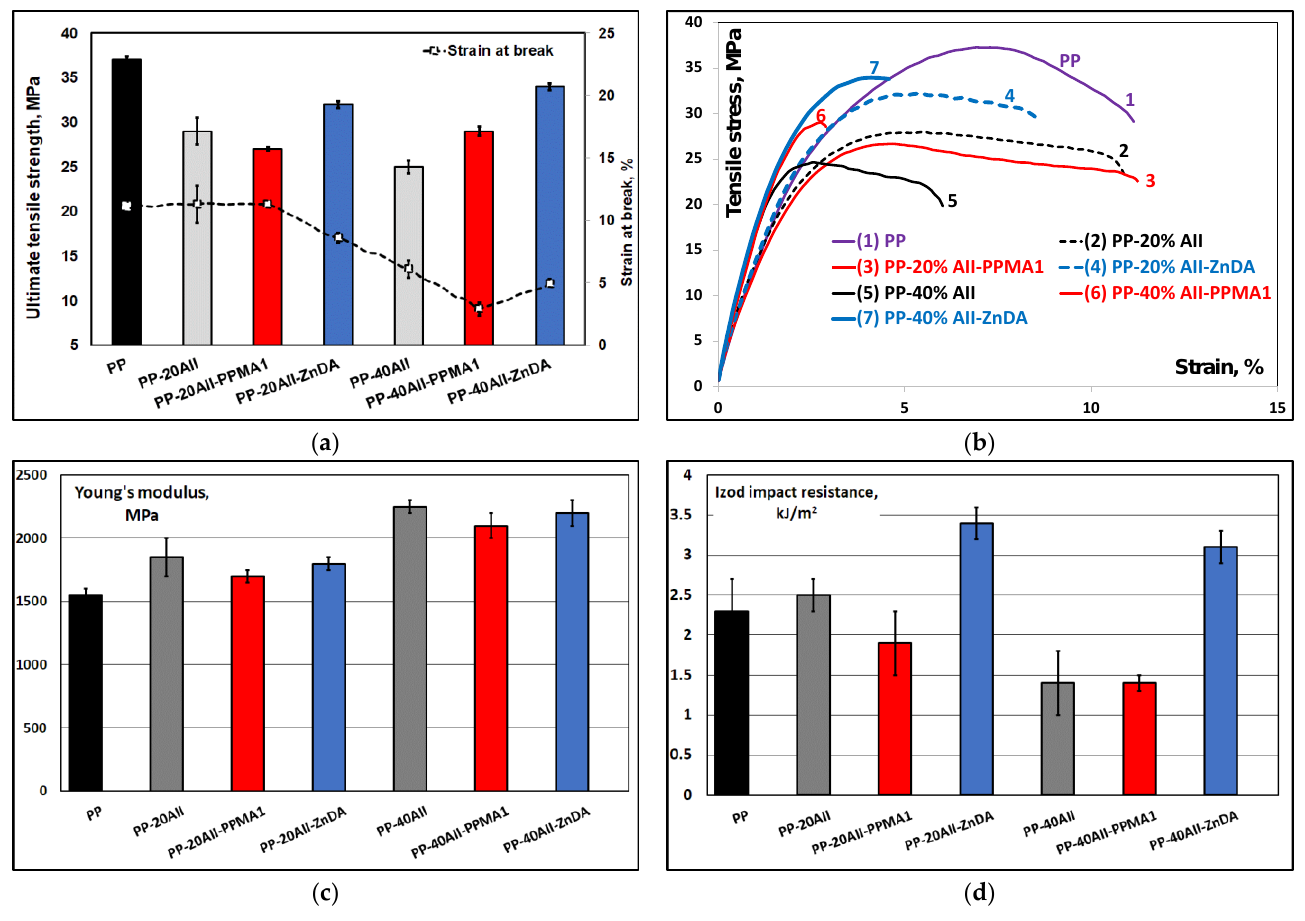
Figure 7. ( a – d ) Comparative mechanical properties of PP and PP – AII composites with/without modifiers: ( a ) tensile strength and strain at break; ( b ) tensile stress–strain curves; ( c ) Young’s modulus; ( d ) impact resistance (Izod).